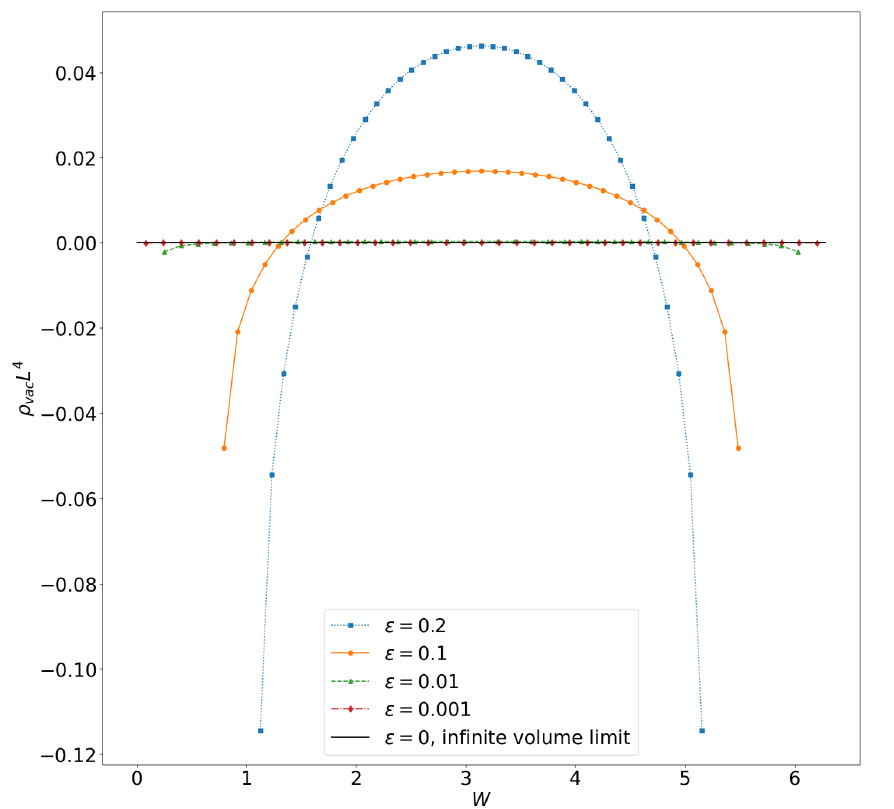
Figure 7 . The dimensionless vacuum energy as a function of the dimensionless parameter, W , for SYM. The numerical evaluation used N = 100000 and N = 500 as the upper limit for the n - n p and p -sums in equations (4.11) and (4.13). The upper limit for the Taylor series in equation (4.17) was taken to be N = 500 . The numerical reliability breaks down near the boundary of the region m hq q i without a tachyon, so the plot is only covers the values in the interval, . The 2 π(cid:15) 2 π(cid:15) , 2 π − 0 . 99 0 . 99 √ −√ value diverges down to negative infinity as W approaches the values W = 2 π(cid:15) and W = 2 π 2 π(cid:15) making the W = π vacuum not quite